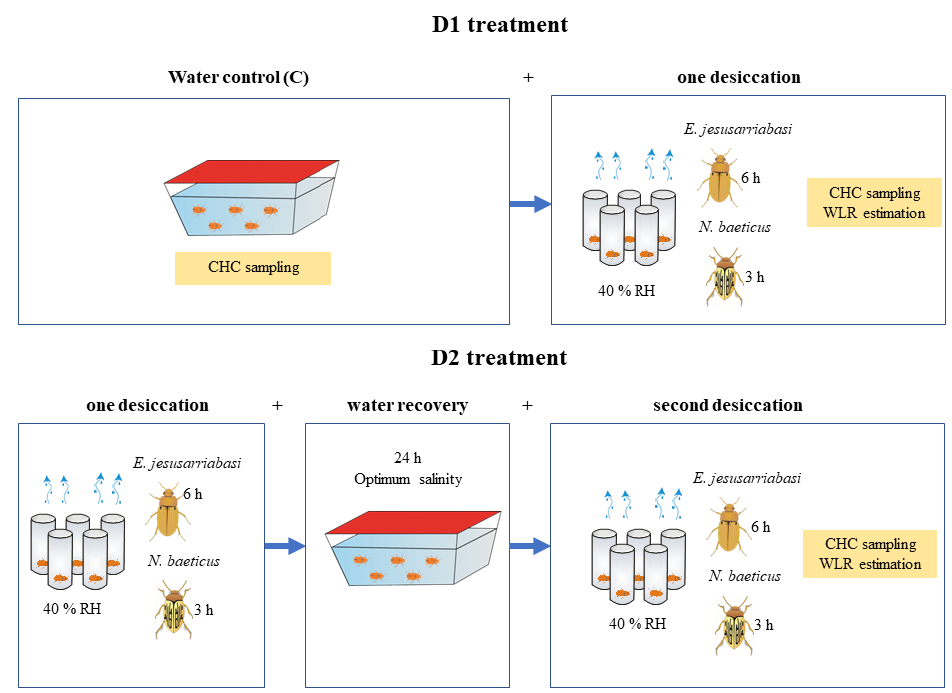
Figure 1. Schematic representation of the experimental design showing the different stress exposure steps and timings for cuticular hydrocarbons (CHCs) sampling and total water loss rate (WLR) estimation.